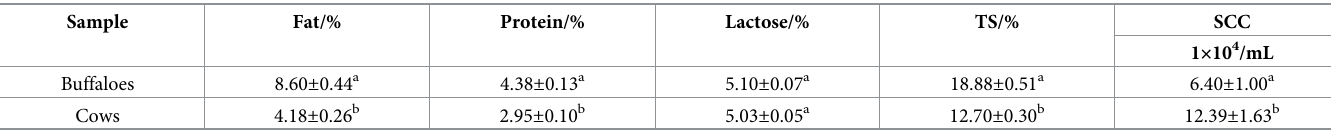
Table 1. Descriptive data of milk composition and SCC of buffaloes and cows. Sample